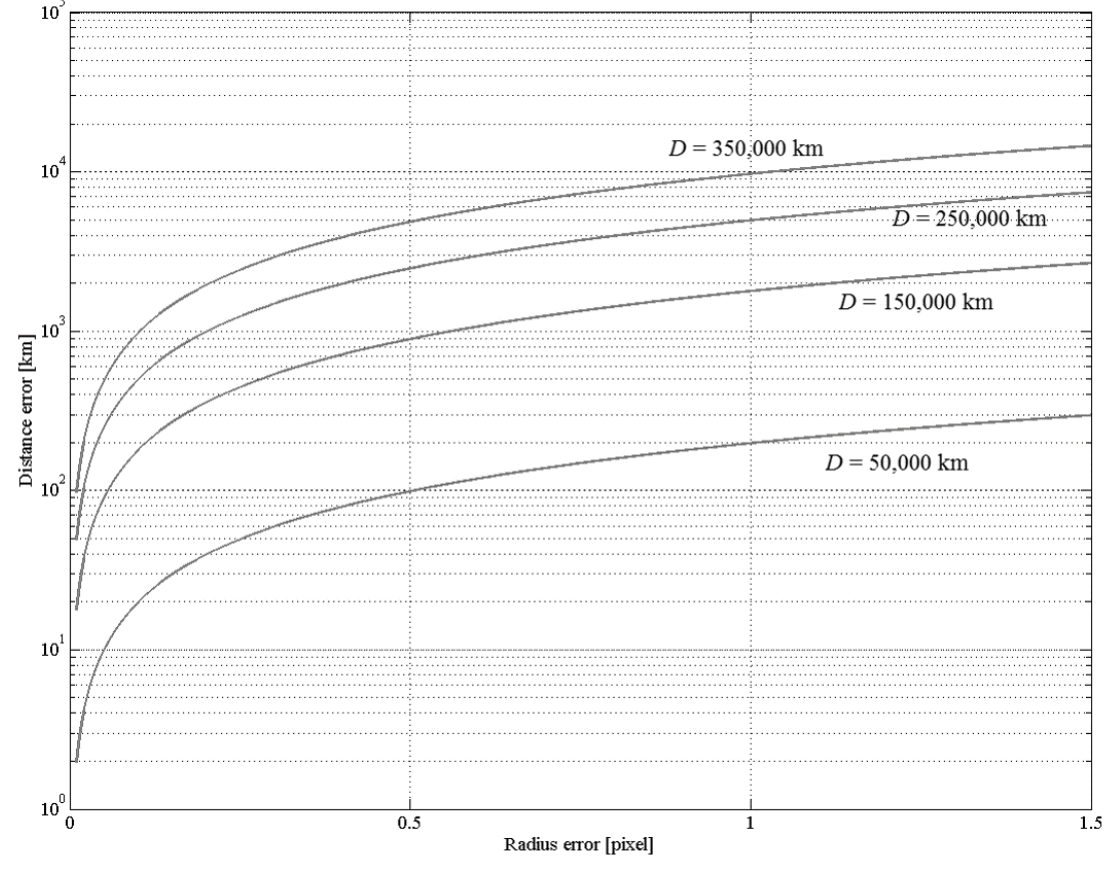
Figure 18. Moon distance error vs .